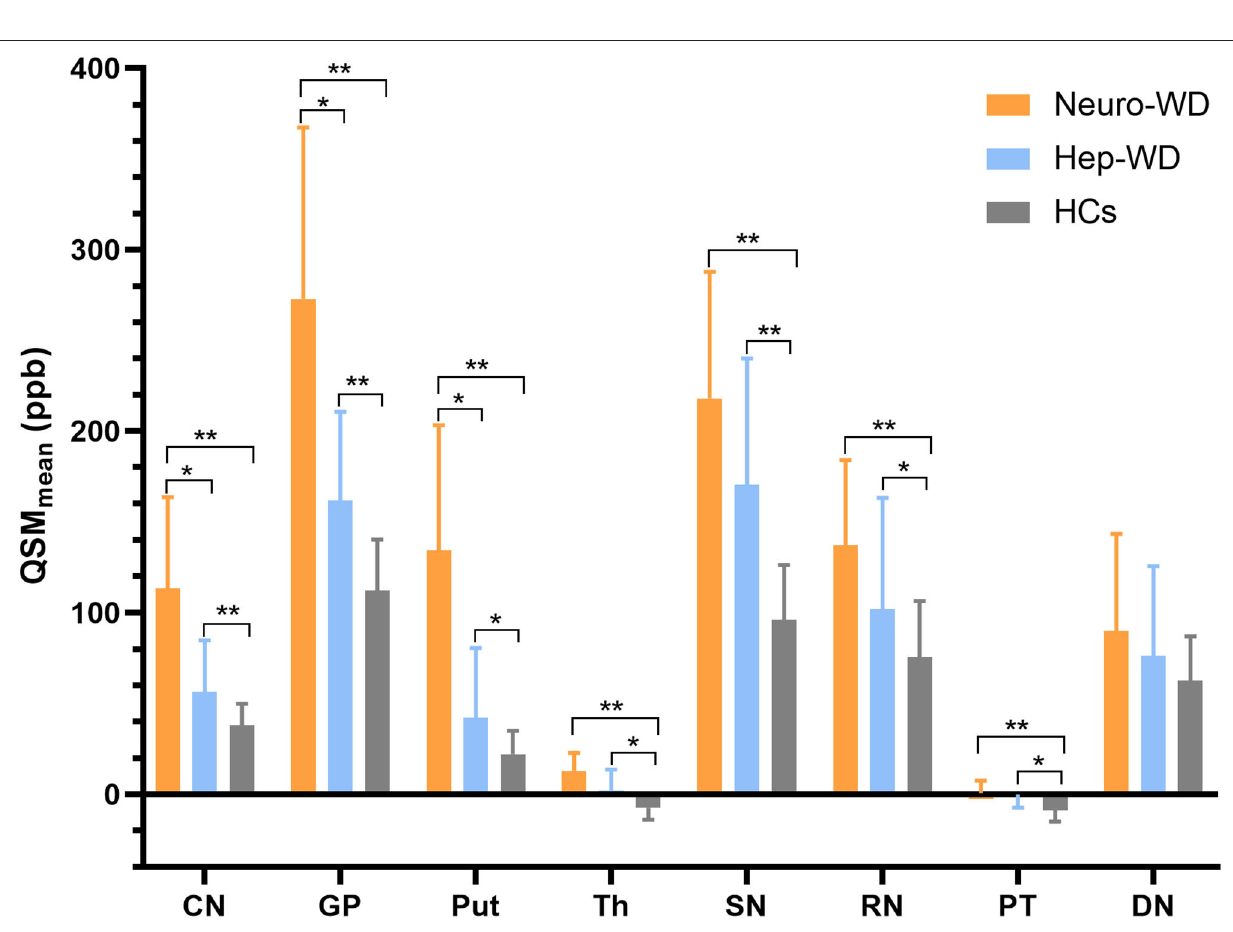
Frontiers in Neuroscience | www.frontiersin.org